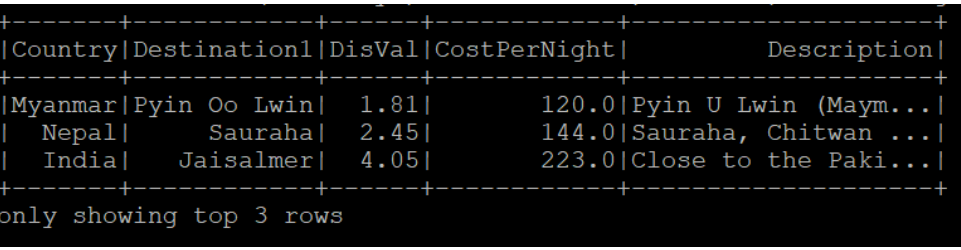
Figure 25. Example 1 of destination suggestions from thematic TRS.